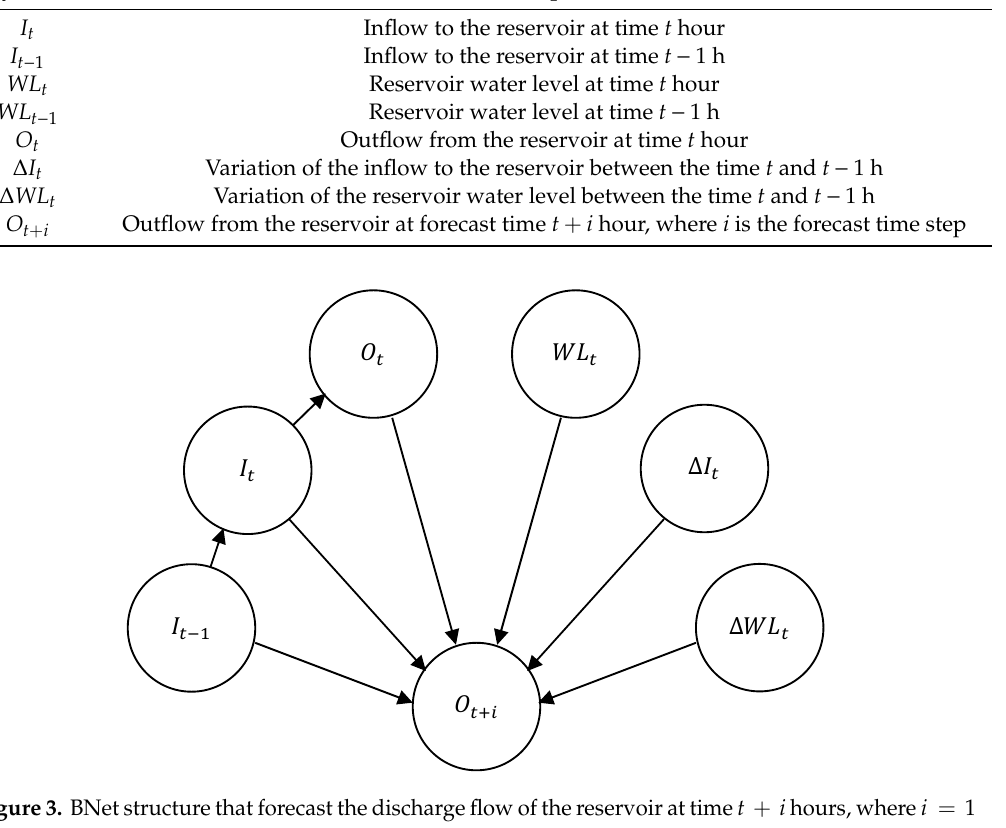
Table 4. Values of the parameter that quantify the forecast quality of the BNet, in a time step from 1 to 5